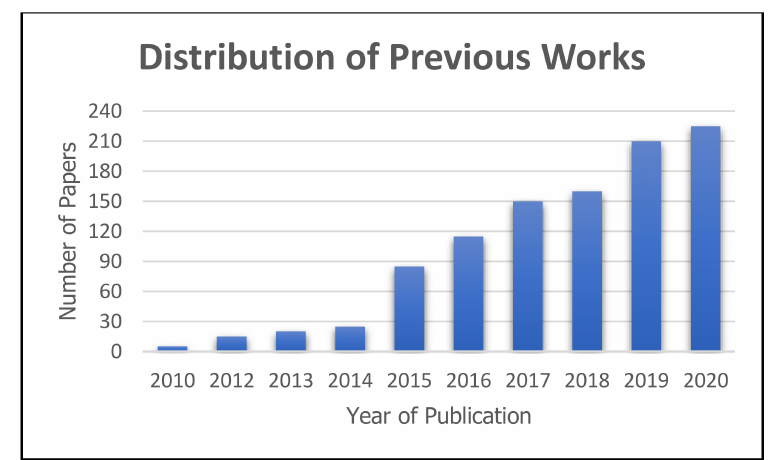
Figure 3. Statistics of distribution of the papers by the publication